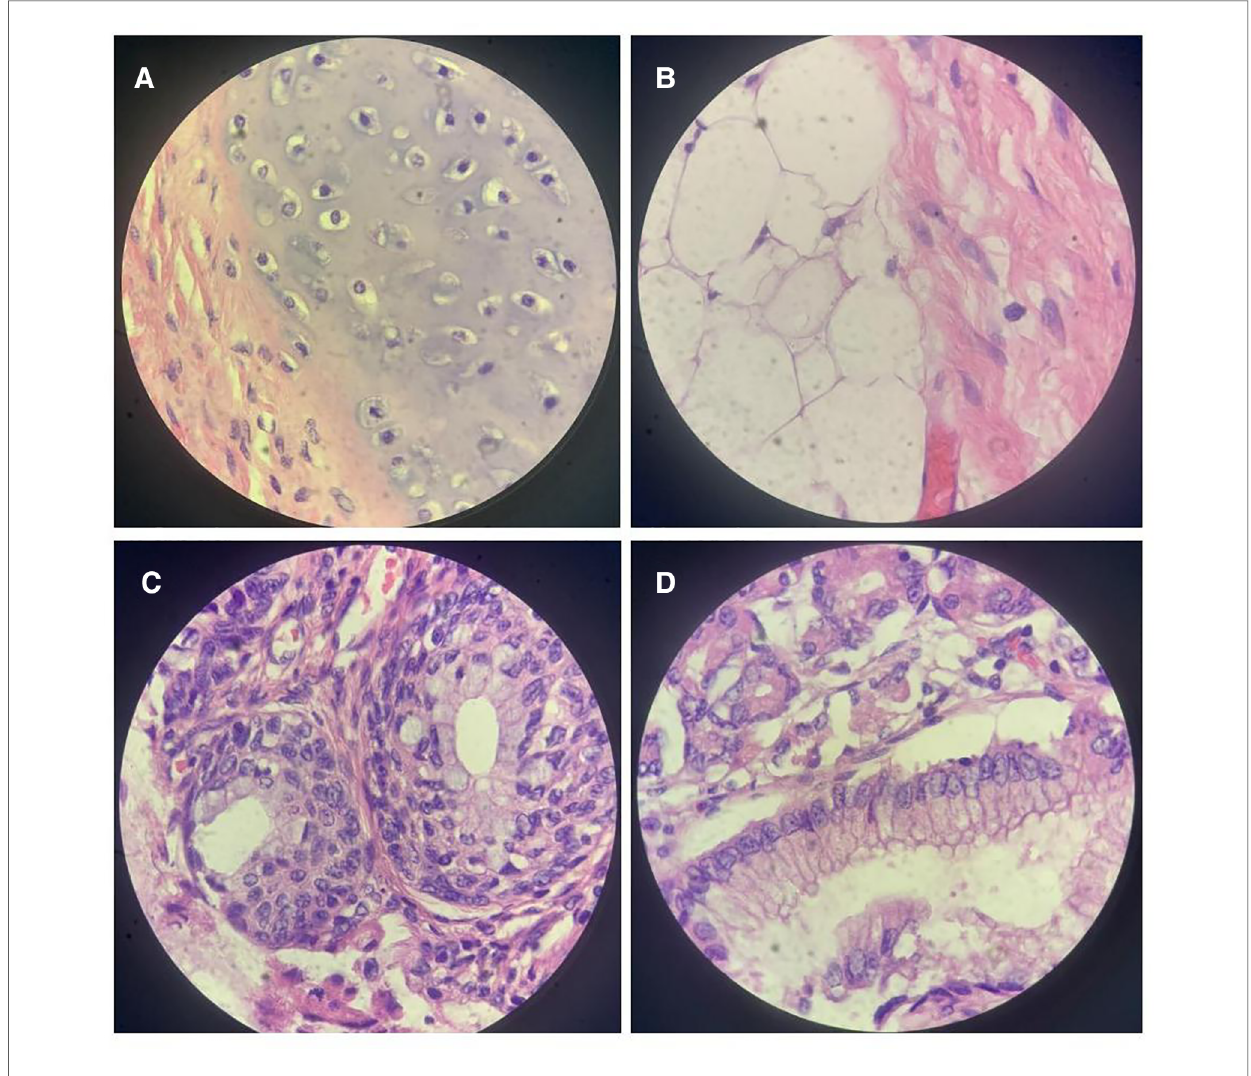
FIGURE 3 High-power view of the tumor. A microscopic examination revealed cartilaginous tissue ( A ), adipose tissue ( B ), glandular tissue ( C ), and epithelial tissue ( D